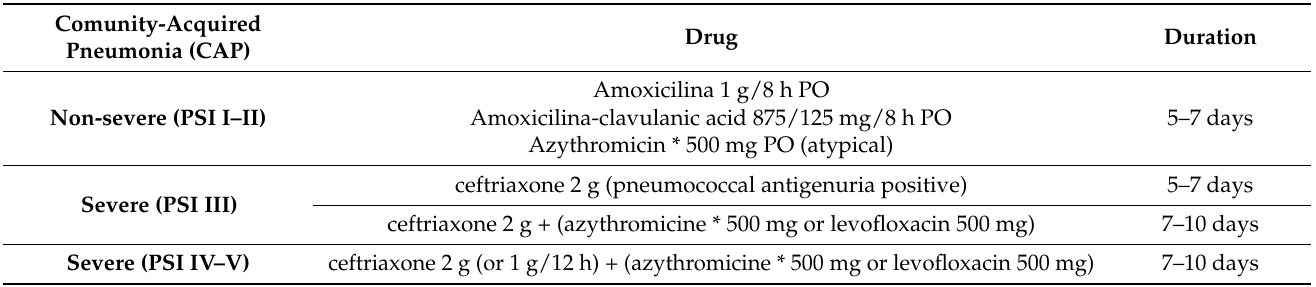
Table 1. An abbreviated overview of the clinical practice-guideline recommendations of reference